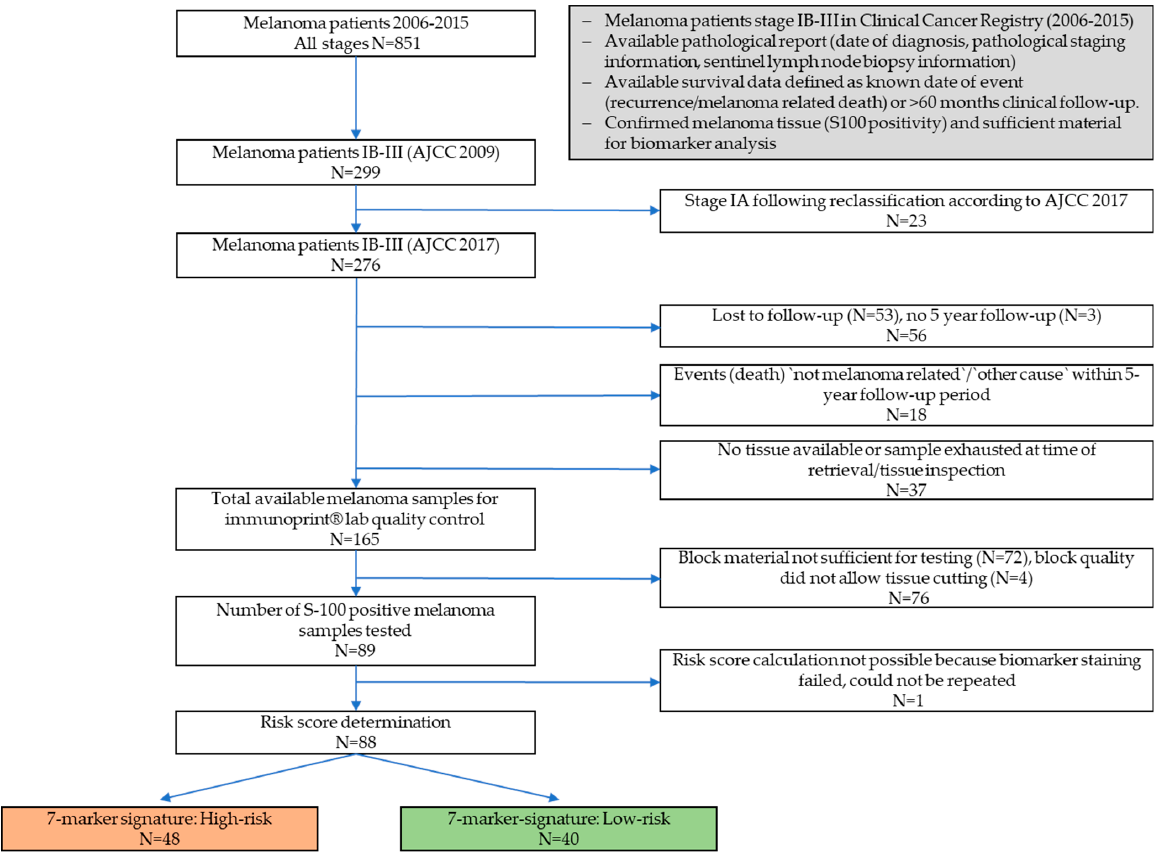
Figure 1. Flow chart depicting the workflow from initial sample collection until generation of final study cohort, staining and statistical evaluation of the 7-marker signature .